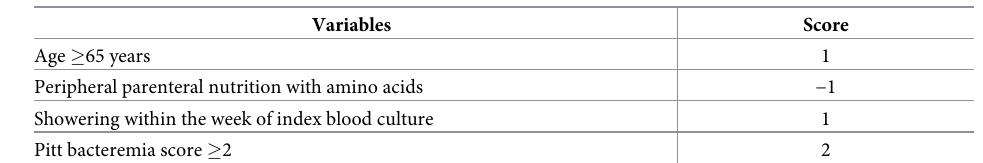
Table 4. PVC-GN scores.